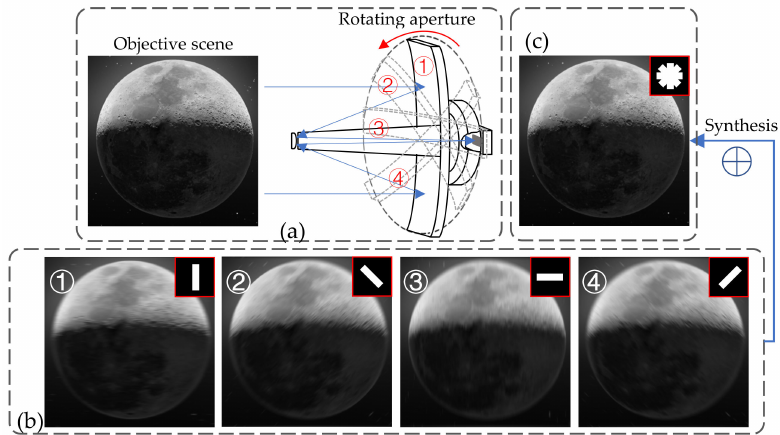
Figure 1. Overview of the RRA system. ( a ) Structural diagram and the imaging mechanism of the RRA system. Sequence images with the aperture at different angles were captured and synthesized together. ( b ) The acquired RRA sequence images with the aperture rotated 0 ◦ , 45 ◦ , 90 ◦ , or 135 ◦ , respectively. The top right inset images are the corresponding apertures. ( c ) Synthesized result of RRA sequence images. The top right inset image is the equivalent aperture